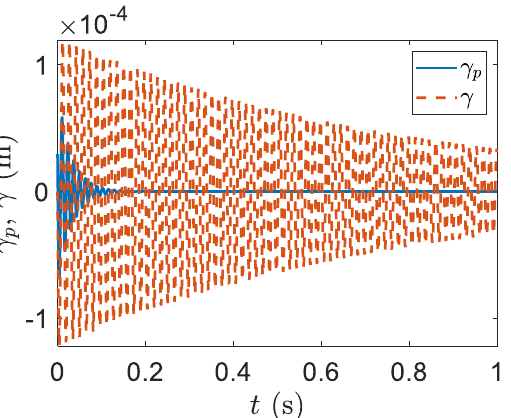
Figure 7. The smart blade system responses of the rotational displacement: (a) the rotational dis- placement of smart and regular blades; (b) the rotational displacement of smart blade.